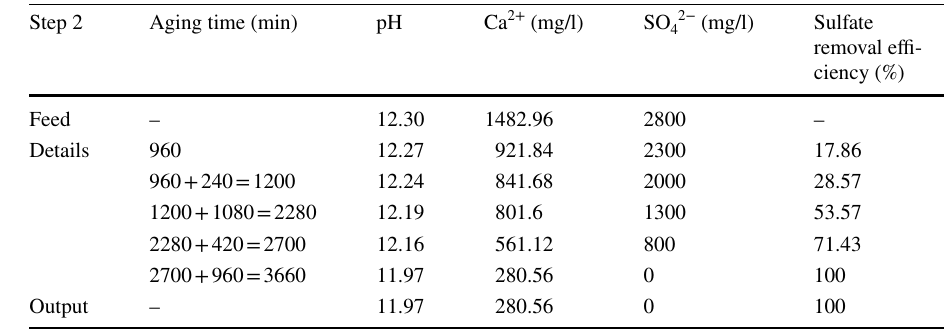
Table 4 Results of second step